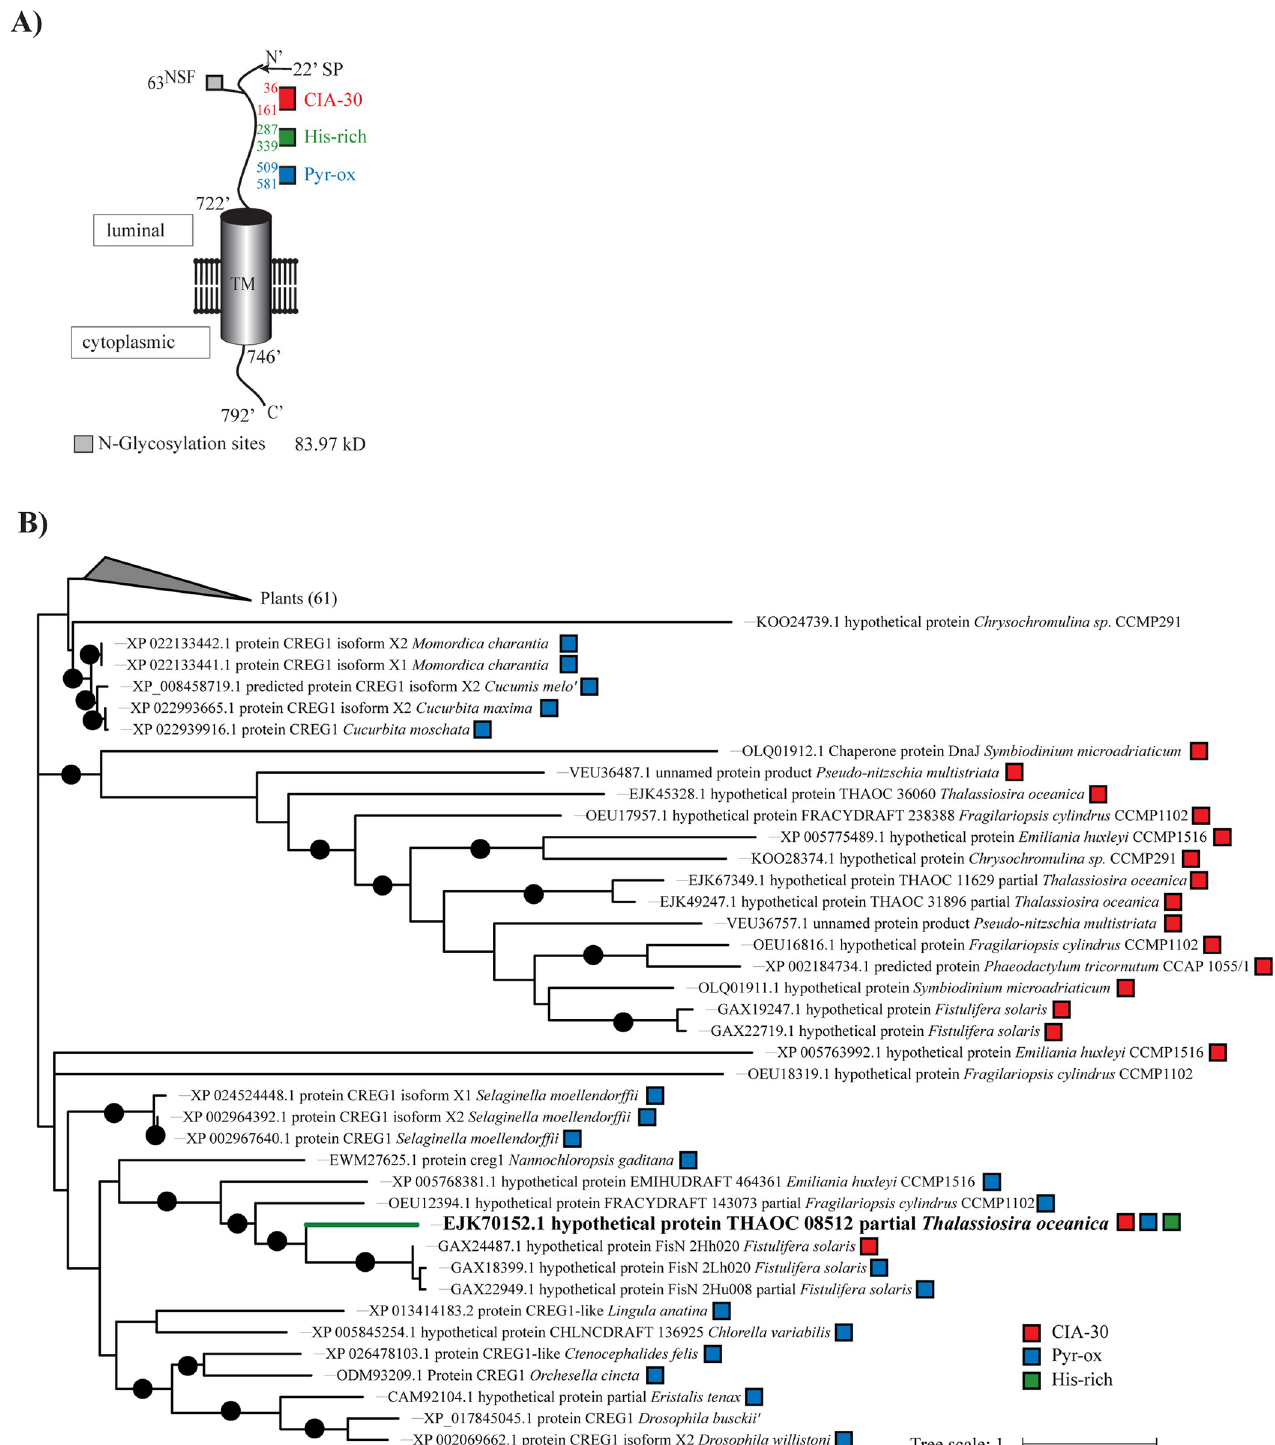
Fig 10. Structure and evolutionary distance to other CREG proteins of CREGx2_ To . (A) CREGx2_ To protein structure. Transmembrane domain (TM) and N-glycosylation sites are indicated as barrels and squares, respectively. (B) Phylogenetic tree of CREG proteins. The T . oceanica sequence is shown in bold (THAOC08512). The maximum likelihood tree was generated in MEGA [44] using the top 100 blastp hits. The sequence alignment is based on a muscle alignment, and the tree was generated with the WAG model and gamma distribution. The black circle represents a bootstrap of > 0.5. Three conserved domains are indicated. Complex I intermediate-associated protein 30 (CIA-30) is in red, Pyrodoxamin-5’phosphate oxidase (Pyr-ox) in blue and histidine-rich region (His-rich) is indicated in green. The signal peptide is abbreviated with SP. https://doi.org/10.1371/journal.pone.0280827.g010 PLOS ONE | https://doi.org/10.1371/journal.pone.0280827 January 24,